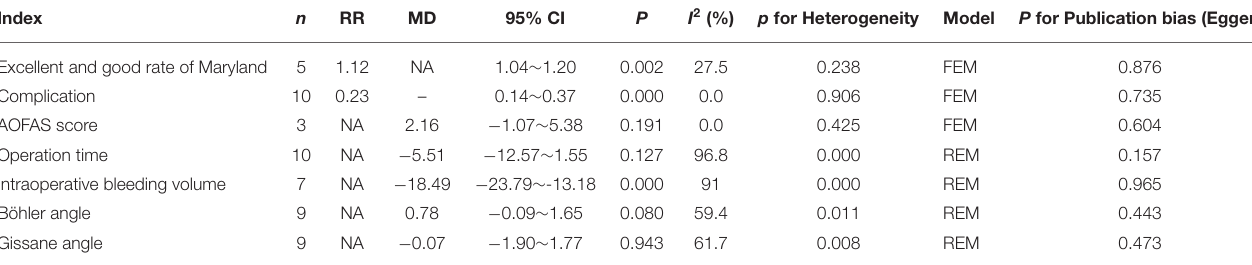
TABLE 2 | Main results of meta-analysis.